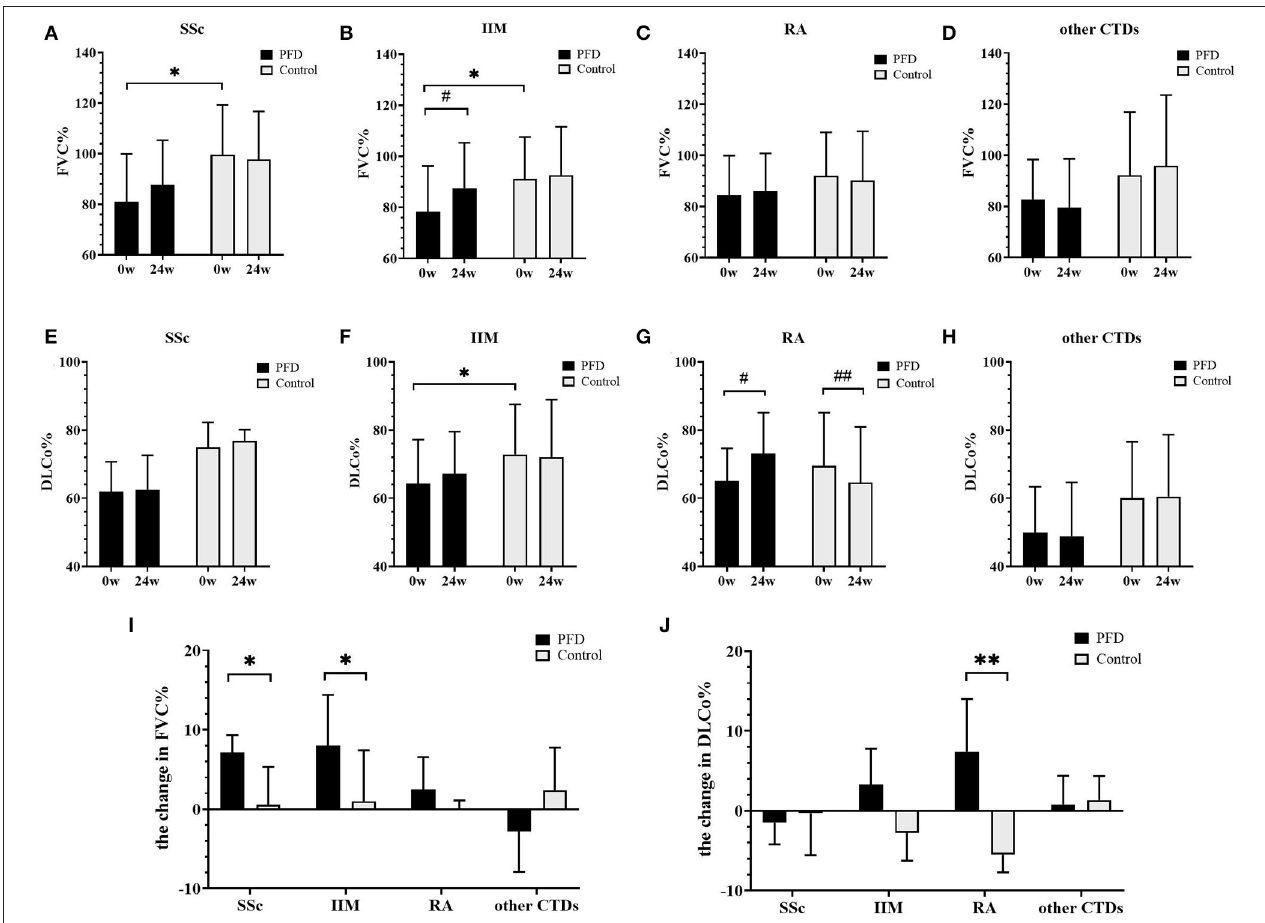
FIGURE 2 | Changes in FVC% and DLCo% in the PFD-treated and control groups of patients with CTD-ILD over 24 weeks. FVC% changes in patients with (A) SSc-ILD, (B) IIM-ILD, (C) RA-ILD, and (D) other patients with CTD from baseline to 24 weeks. DLCo% changes in patients with (E) SSc-ILD, (F) IIM-ILD, (G) RA-ILD, and (H) other patients with CTD from baseline to 24 weeks. The changed value of (I) FVC% and (J) DLCo% in patients with SSc, IIM, RA, and other patients with CTD. * p < 0.05, ** p < 0.01 compared to the no-PFD control; # p < 0.05, ## p < 0.01 compared to the baseline value. Baseline and 24-week pulmonary function data are presented as the means and standard deviations and were tested by the unpaired t -test. The other results are presented as medians and ranges and were tested by the Mann-Whitney U